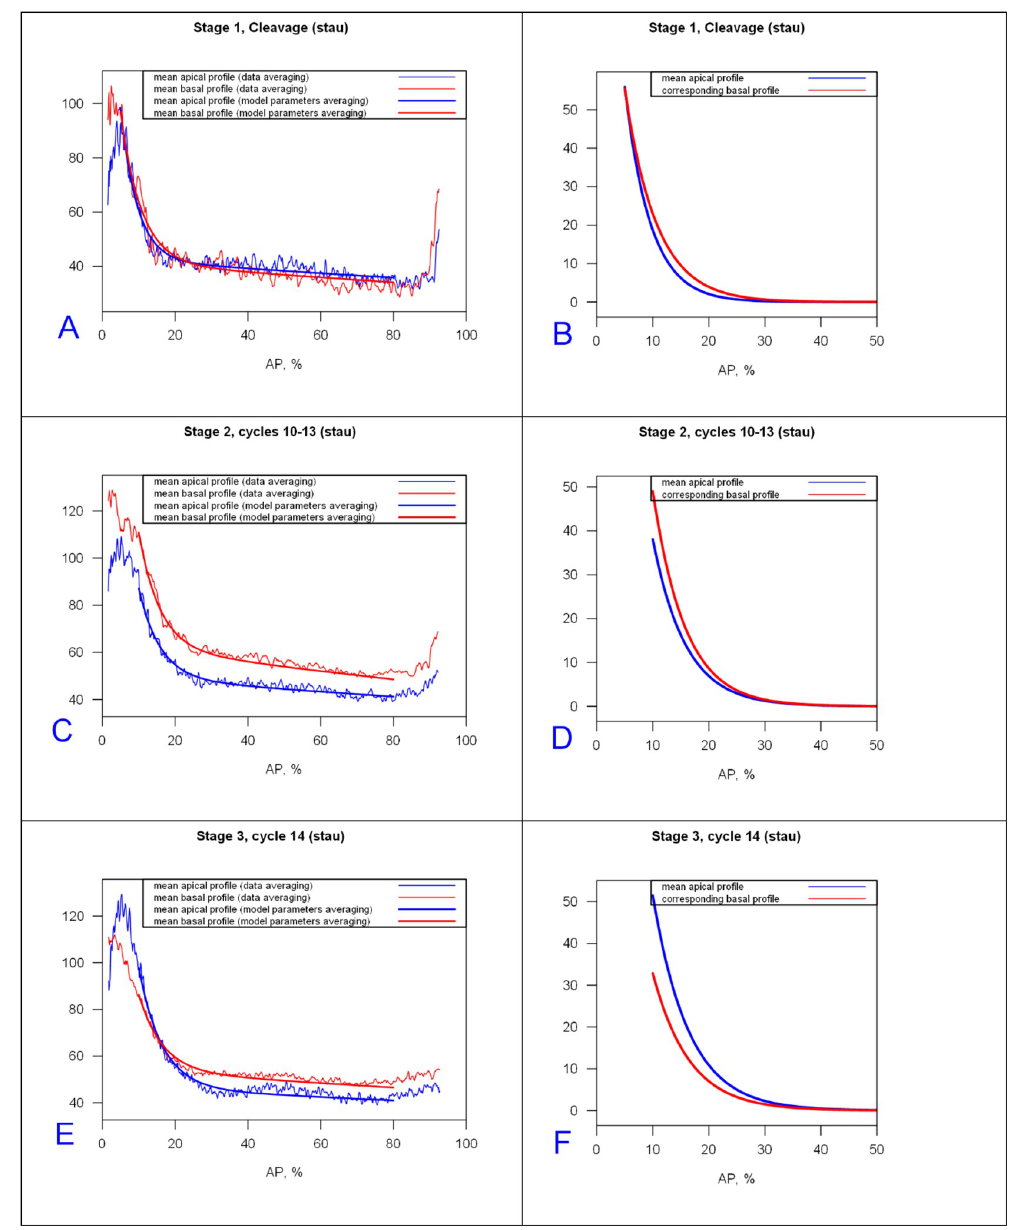
Fig 6. Stau prototypical profiles and prototypical anterior exponentials for cleavage, cc10-13 and cc14 stages (fit to (10,80) %EL). (A,C,E) Profiles of mean model parameters overlaid on averaged data. B,D,F) Anterior gradients only for the mean profiles in